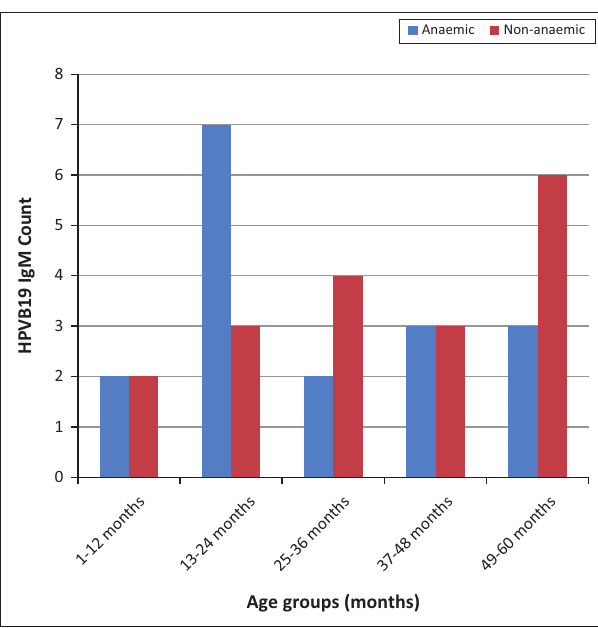
FIGURE 1: Distribution of human parvovirus B19 infection among age groups of anaemic and non-anaemic pre-school children in Ilorin, Nigeria, November